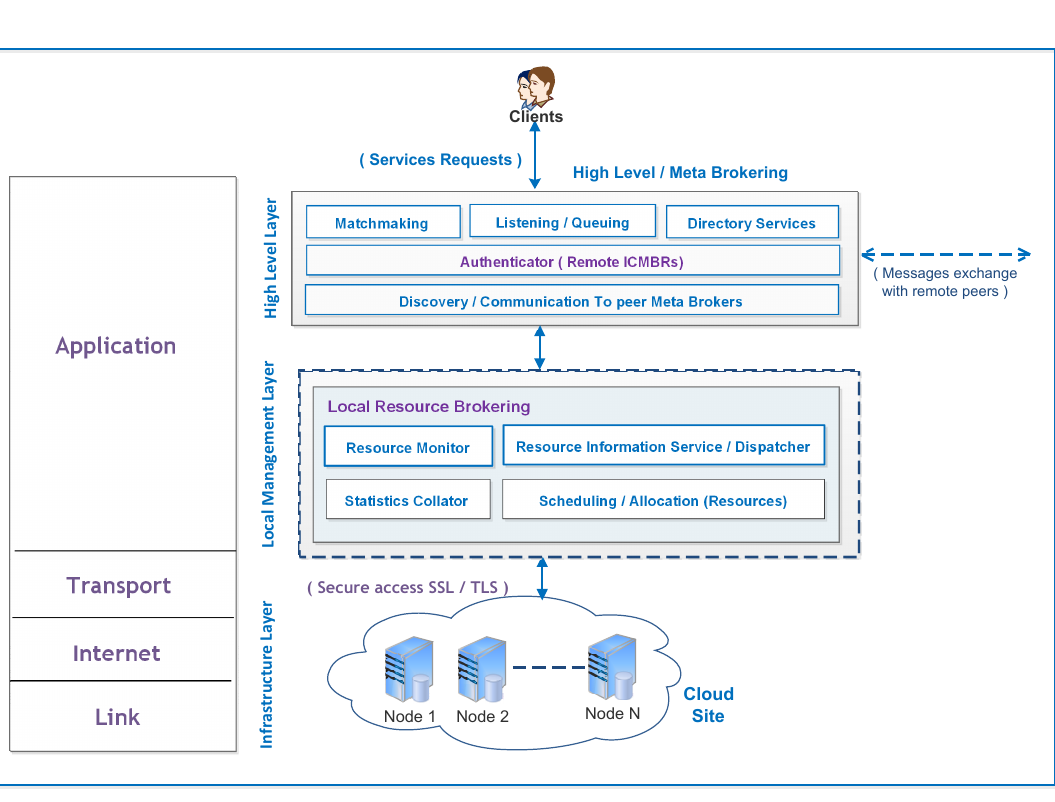
Figure 6. High-level design (federated site) mapping with TCP/IP